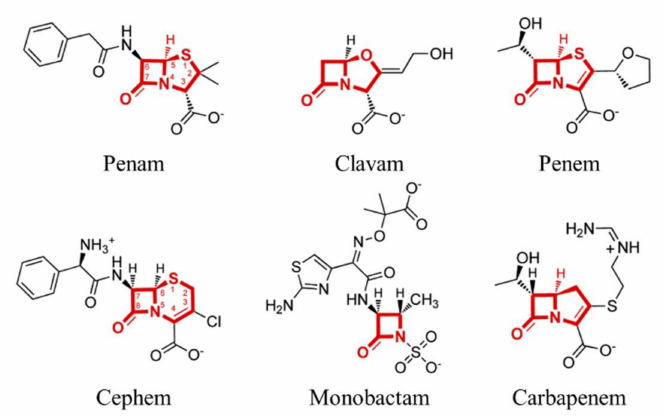
Figure 6. Chemical structures of the selected examples from six β -lactam structural categories. The core scaffolds (highlighted in red) are similar. Figure modified from